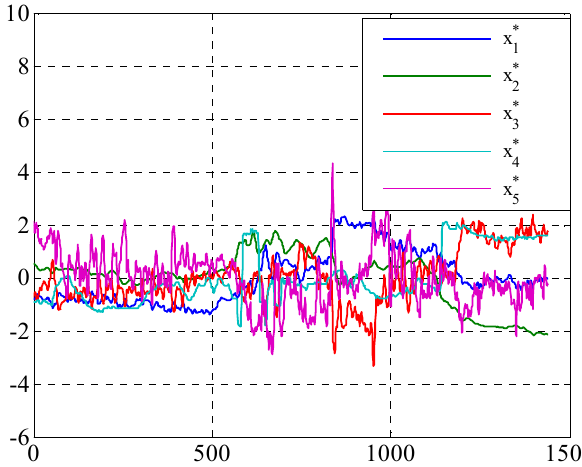
Figure 14. Five standardized variable x ∗